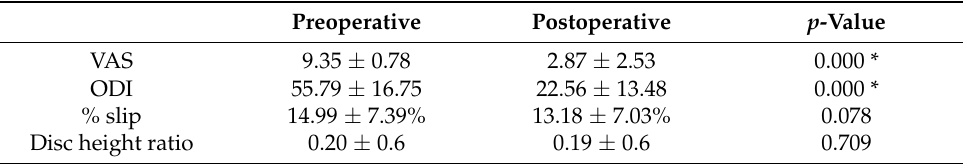
Table 3. Comparison of clinical outcomes and slippage percentage between preoperative and postoperative periods. VAS, visual analogue scale; ODI, Oswestry disability